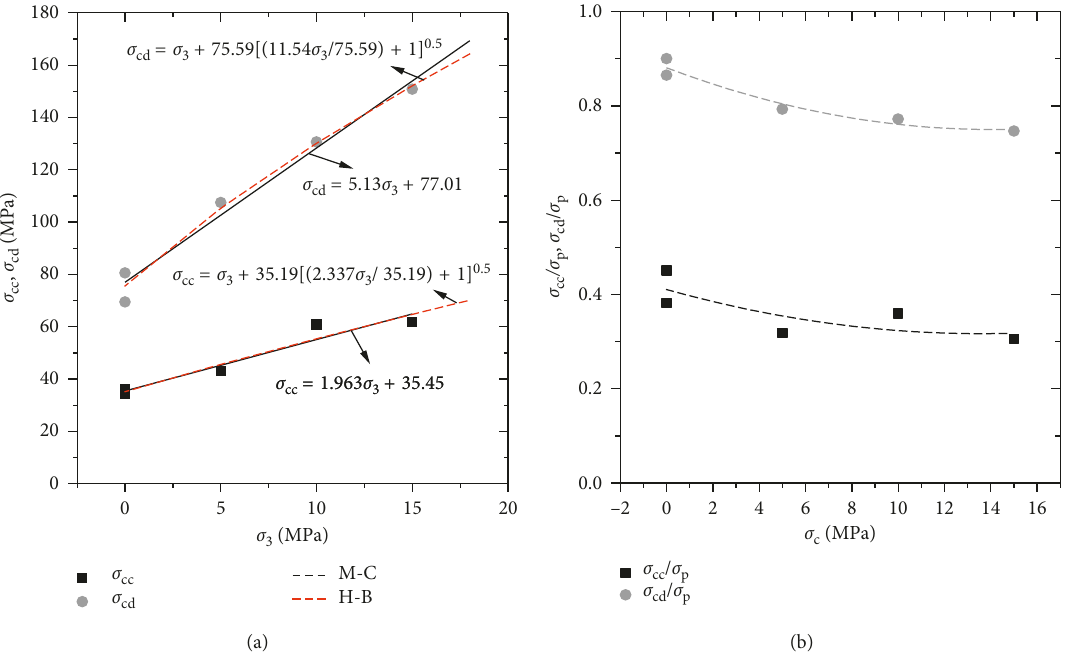
Figure 6: (a) Variations of the crack closure and crack damage stresses with the confining pressure; (b) relationship between the crack closures, damage stress levels, and confining pressures.